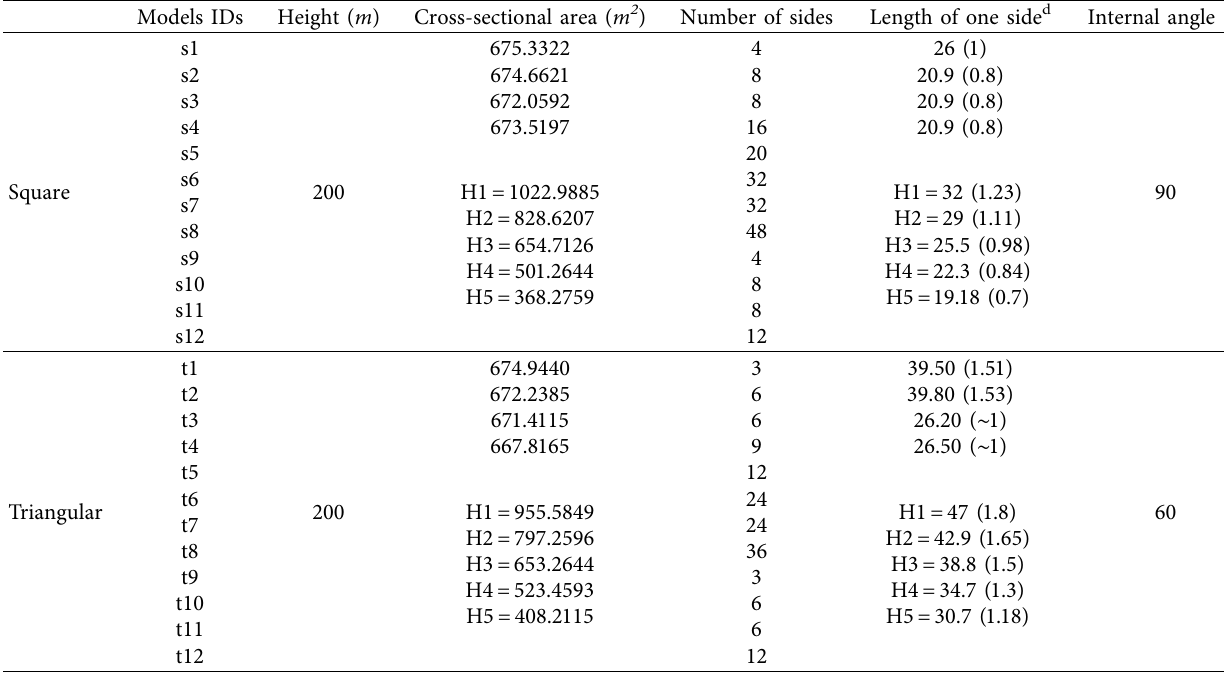
Table 2: Models geometry